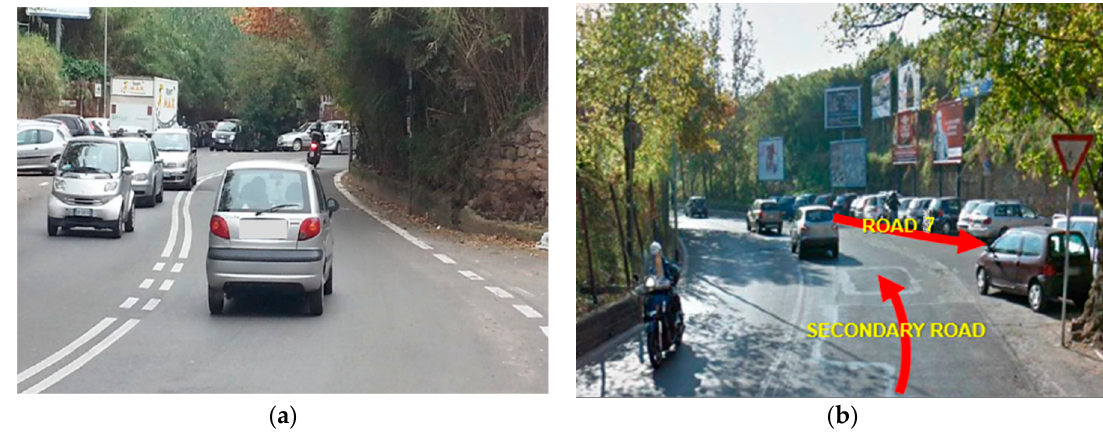
Figure 8. Section n.4 of ROAD7: example of surveyed conditions. ( a ) Low planimetric radius G1 ( B i = 3); ( b ) Hazardous maneuver J3 ( B i = 3).